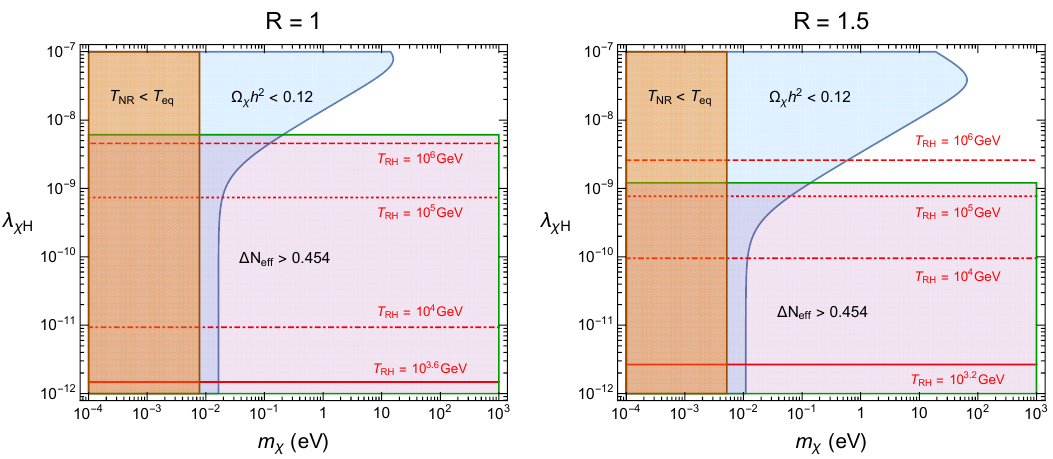
Figure 7 . Parameter space for the DM relic density produced by non-thermal mechanisms in the plane of m (cid:31) and (cid:21) (cid:31)H . The relic density satis(cid:12)es (cid:10) (cid:31) h 2 < 0 : 12 in light blue region while dark matter becomes non-relativistic after matter-radiation equality in light orange region. In purple region, dark matter contributes to (cid:1) N e(cid:11) > 0 : 454 during BBN. Contours with reheating temperature, T RH = 10 6 ; 10 5 ; 10 4 ; 10 3 : 6 (10 3 : 2 ) GeV, are shown on left(right) in red dashed, dotted, dot-dashed, p and solid lines, respectively. R = (cid:24) 1 = (cid:24) 2 = 1 ; 1 : 5 is chosen on left and right plots, respectively, and r = 0 : 01 is taken for both